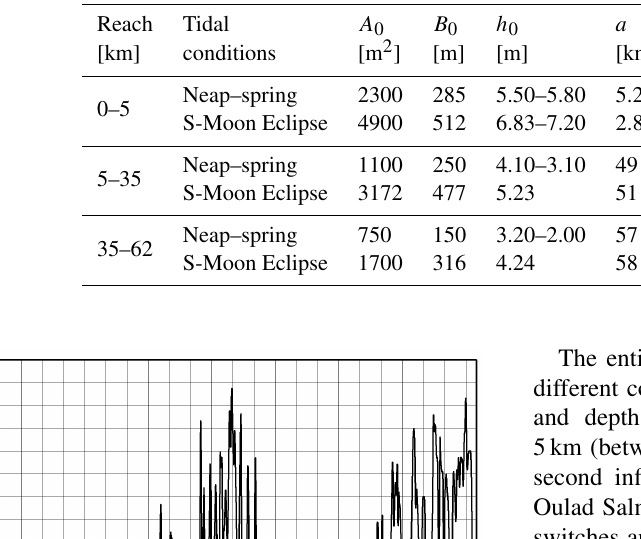
Table 3. Geometric characteristics in the Sebou estuary.